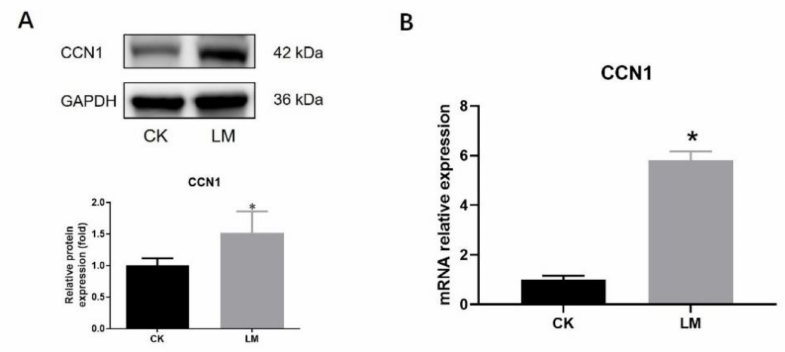
Figure 5. The changes in CCN1 protein response to L. monocytogenes infection in organoids. ( A ) West-